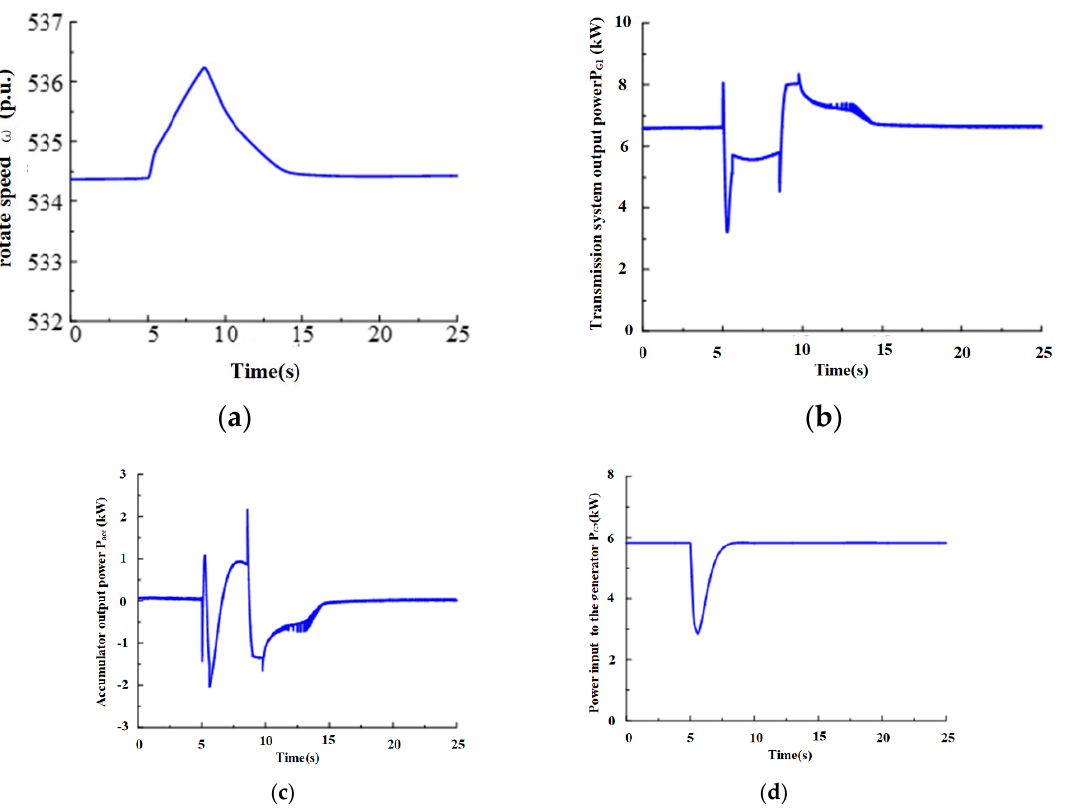
Figure 19. Rotor combined with energy storage frequency modulation simulation response curve. ( a ) The rotor-speed response curve. ( b ) Transmission power output curve. ( c ) Accumulator power output curve. ( d ) Power input to generator curve.